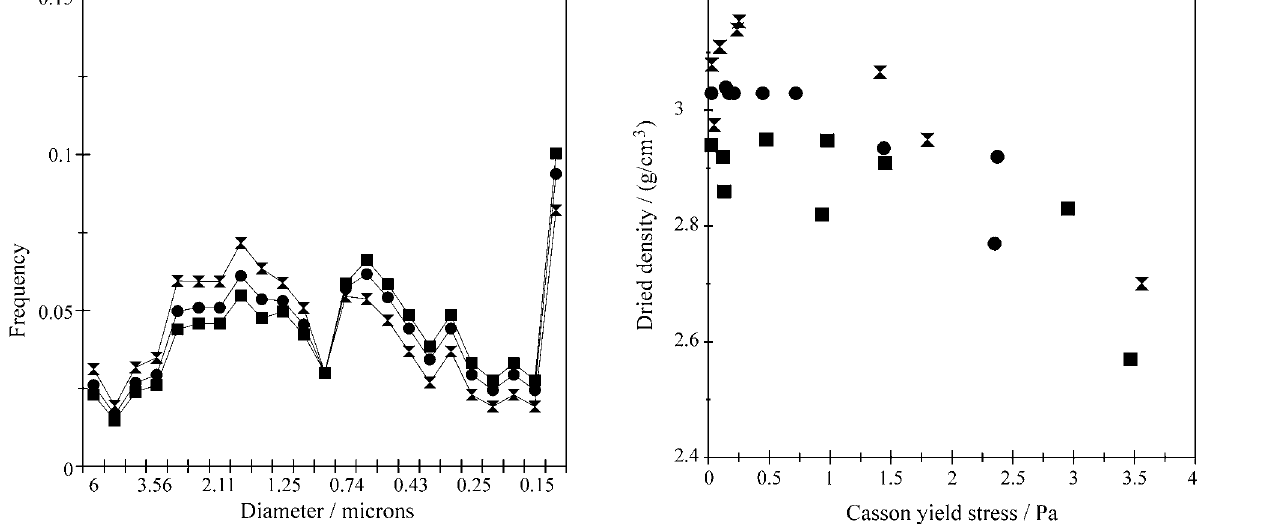
Figure 5. Frequency vs. Particle diameter curves calculated from data of Fig. 4 and volume fraction of each component for: • stoichiometric, with a 6 wt% excess of alumina and x with a 10 wt% excess of zircon powder mixtures.